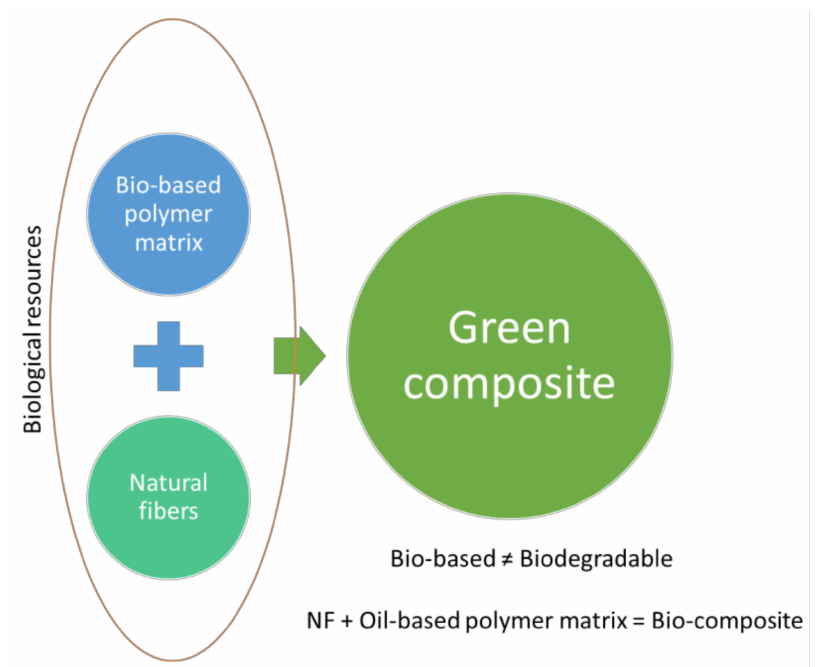
Figure 5. Bio-composites, bio-based composites and green